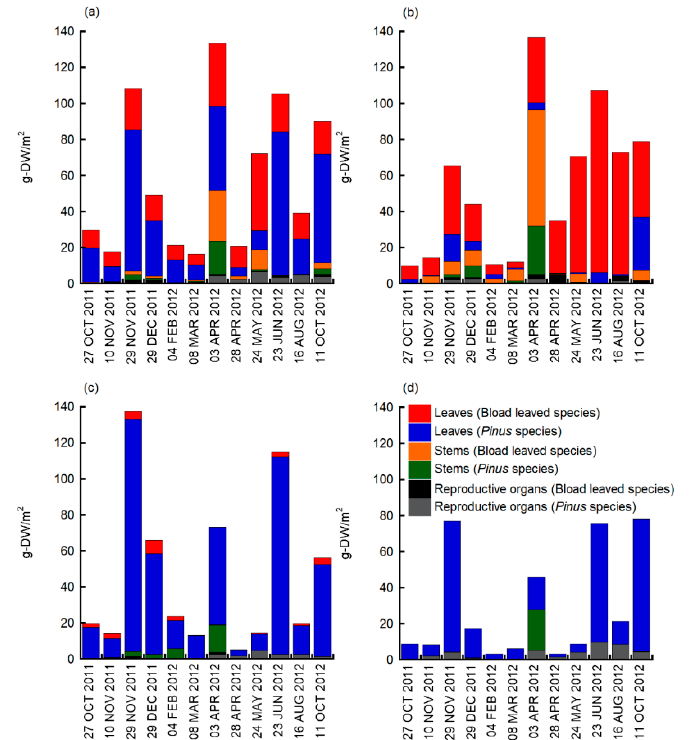
Figure 3. Dry weight of litter collected with five 0.5 m × 0.5 m litter traps established in each quadrat, ( a ) quadrat A (mixed stand), ( b ) quadrat B (broadleaf stand), ( c ) quadrat C ( Pinus dominated stand), and ( d ) quadrat D (pure Pinus stand) in the Sanri-Matsubara Forest, south-western Japan, Litter traps were established on 19 October 2011 and collected litters until 1 November 2012. The date shows the middle day of each sampling period.